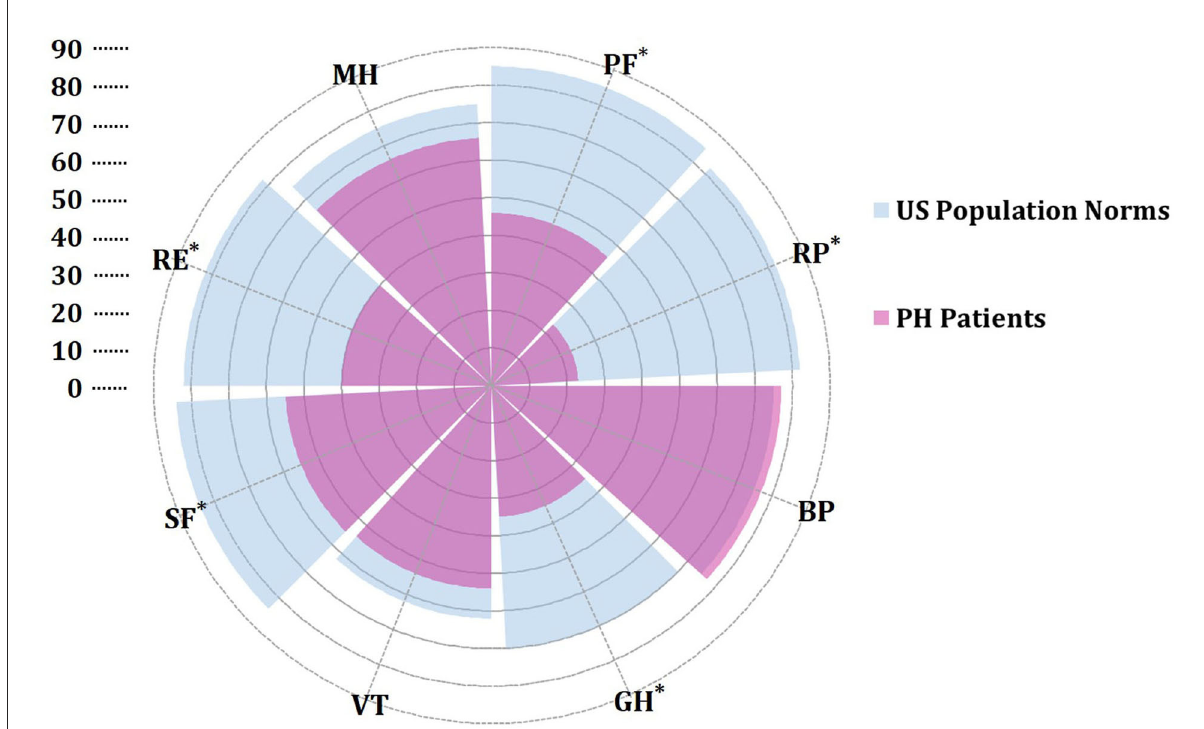
FIGURE2 Rose radar plot of the individual domain in pulmonary hypertension (PH) vs. U.S. population normative values. All values are presented as means. *A p < 0.05 for comparison with U.S. population norms. Purple represents SF-36 scores in patients with PH. Blue represents SF-36 scores of U.S. population norms from the literature (21). BP, body pain; GH, general health; MH, mental health; PF, physical functioning; RE, role emotional; RP, role physical; SF, social functioning; VT, vitality.